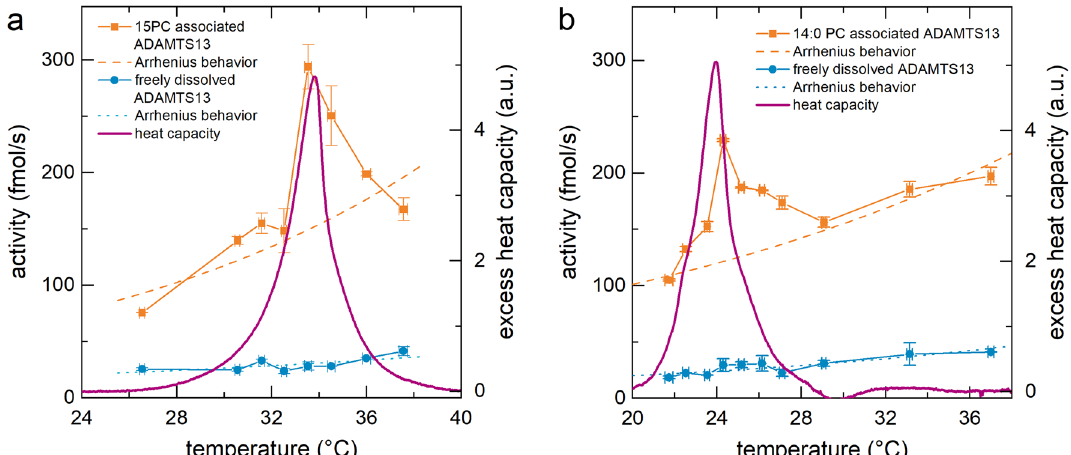
Figure 1. ADAMTS13 activity as a function of temperature and membrane phase state for ( a ) 15:0PC LUV and ( b ) 14:0PC LUV. Blue circles are the reference values for ADAMTS13 in the dissolved state. Orange Squares represent the activity for ADAMTS13 at 15:0 PC and 14:0 PC membranes, respectively. The pink solid line represents the excess heat capacity of the respective system. The activity of membrane associated enzyme was corrected according to the “Supplementary Information” by a simple factor due to optical reasons. Error bars represent the standard deviation of three independent